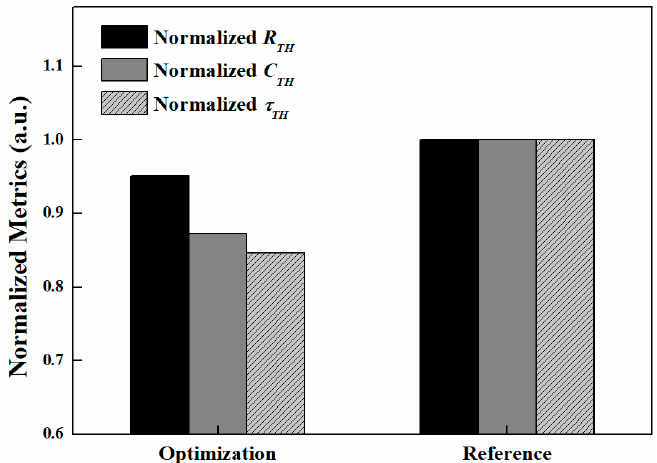
Figure 11. Optimization results of R TH , C TH , and τ TH properties.